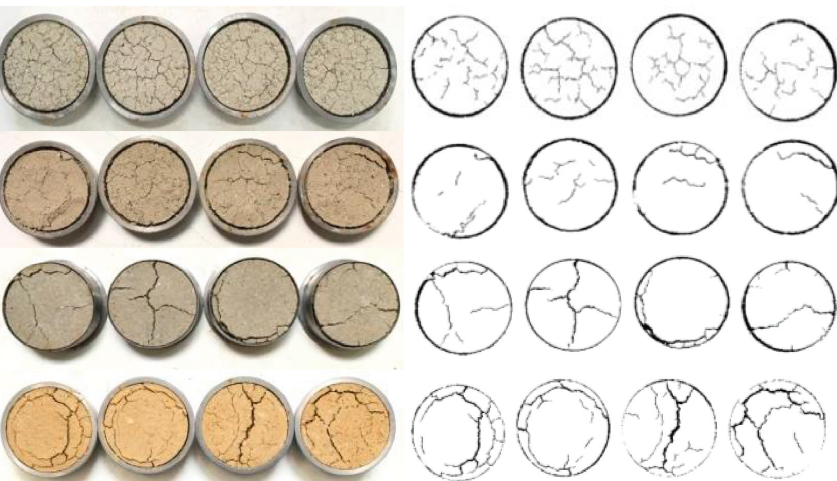
Figure 3: Initial and binary images of three different samples at the ending of tests (1.8 g/cm 3 , 1.6g/cm 3 , and 1.5 g/cm 3 of cyan mudstone and 1.8g/cm 3 of yellow mudstone from top to bottom).